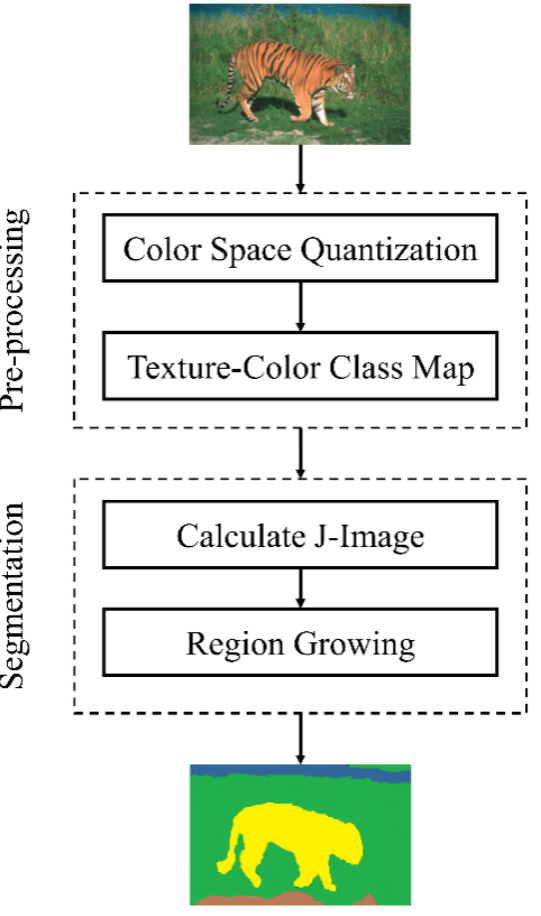
Figure 2. A general scheme of texture-enhanced JSEG (T-JSEG) segmentation method. At the pre- processing level, the HSV color space is firstly quantized and all pixels of the image are then mapped to their corresponding bins. At the segmentation level, the J-image and a class map for each win- dowed color region are calculated, and then a clustering/growing algorithm is applied to obtain distinct